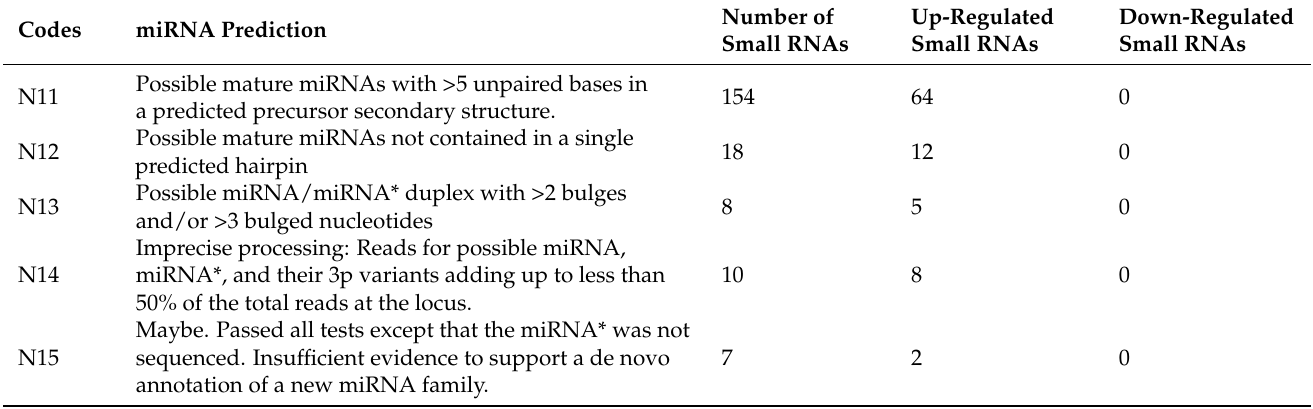
Table 4. Differentially expressed milRNAs candidates predicted by